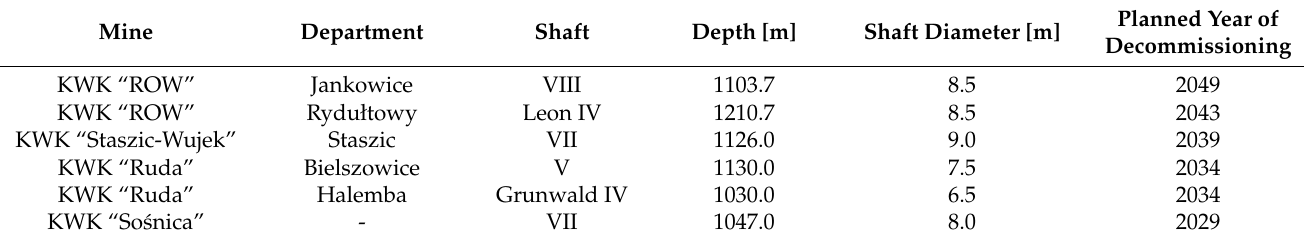
Table 1. List of shafts over 1000 m deep in PGG